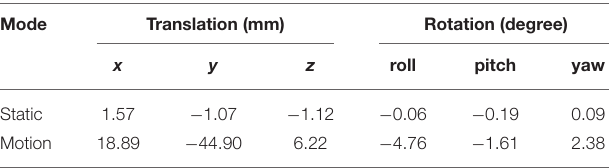
TABLE 1 | The collected error compensation values for the flange-based hand-eye calibration methods in static and motion modes.